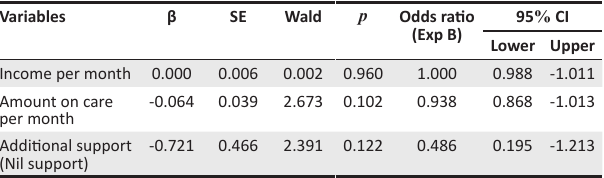
TABLE 4: Logistic regression analysis of the factors associated with suicidality amongst the participants ( N = 160). Variables